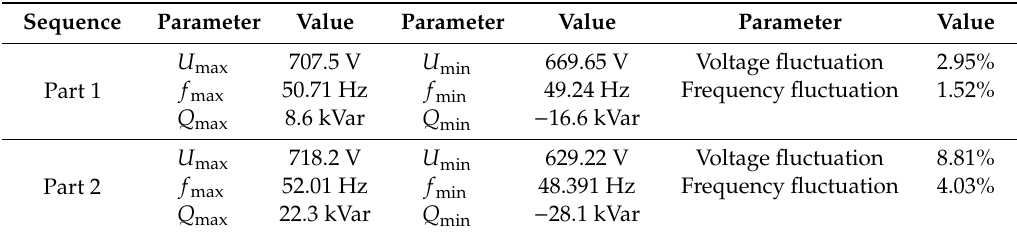
Table 2. The list of parameters for balance load Lb